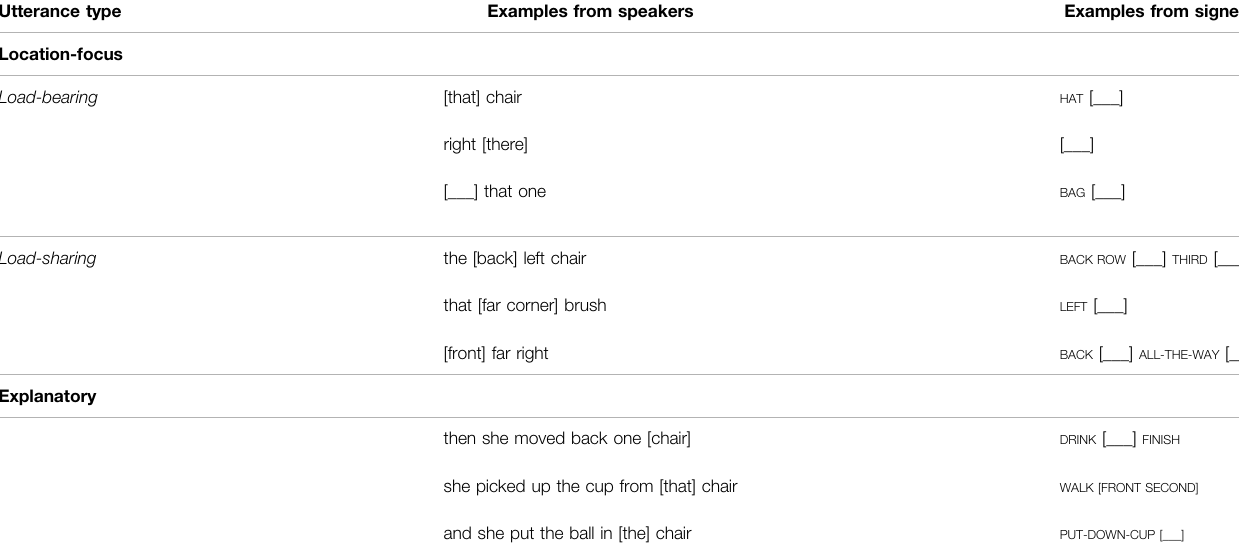
TABLE 1 | Examples of utterance